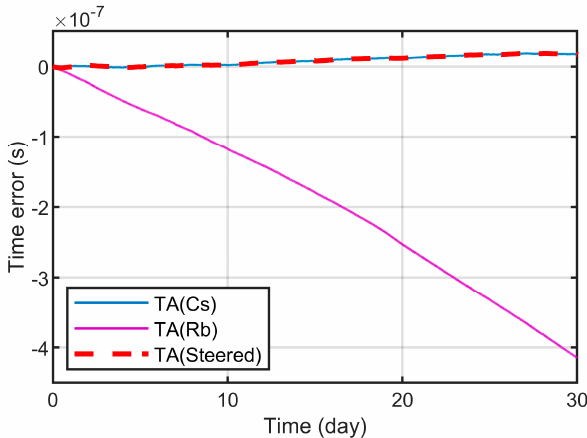
Figure 13. Phase difference of TA(Cs), TA(Rb), TA(Steered).